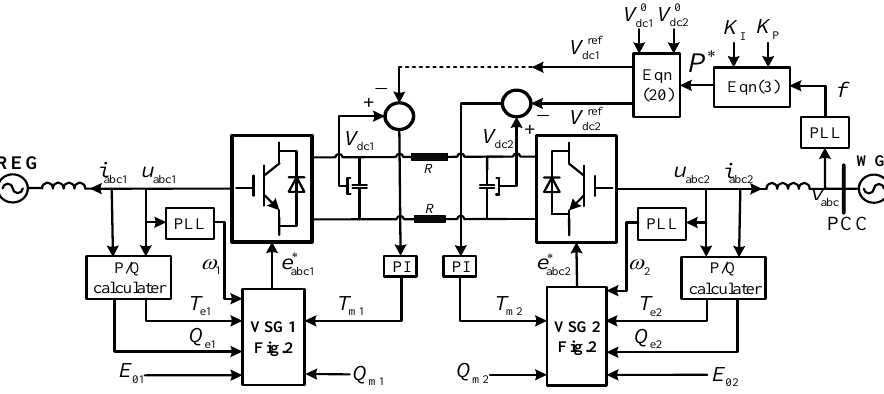
Figure 3. Proposed VSG-based coordinated DC Voltage control strategy for VSC-HVDC. The frequency of the weak grid could be obtained through the voltage v abc at the point of common coupling (PCC) with PLL, which is used to calculate the active power reference P * by Equation (3). Then, the DC voltage references are calculated according to Equation (20). Since these processes are implemented in the receiving end, the V ref could dc2 be used to generate the input torque for VSG2 directly. While the sending end VSC station is far away from the receiving end, the communication infrastructure will be introduced to transmit the V ref , which is shown in the above figure with a dotted line. Similarly, the dc1 input torque for VSG1 is computed by the PI controller on the deviation between V ref dc1 and V dc1